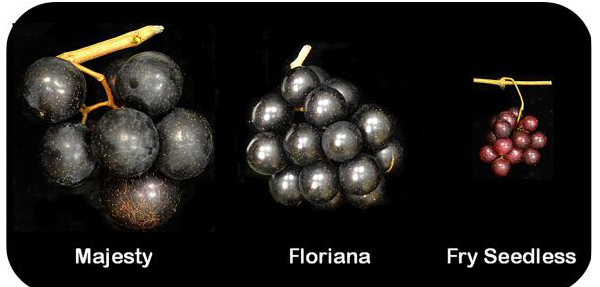
Figure 3. Close-up cluster view of muscadine cultivars Majesty (female flower, seeded), Noble (perfect flower, seeded), and Fry seedless (perfect flower, parthenocarpy seedless).